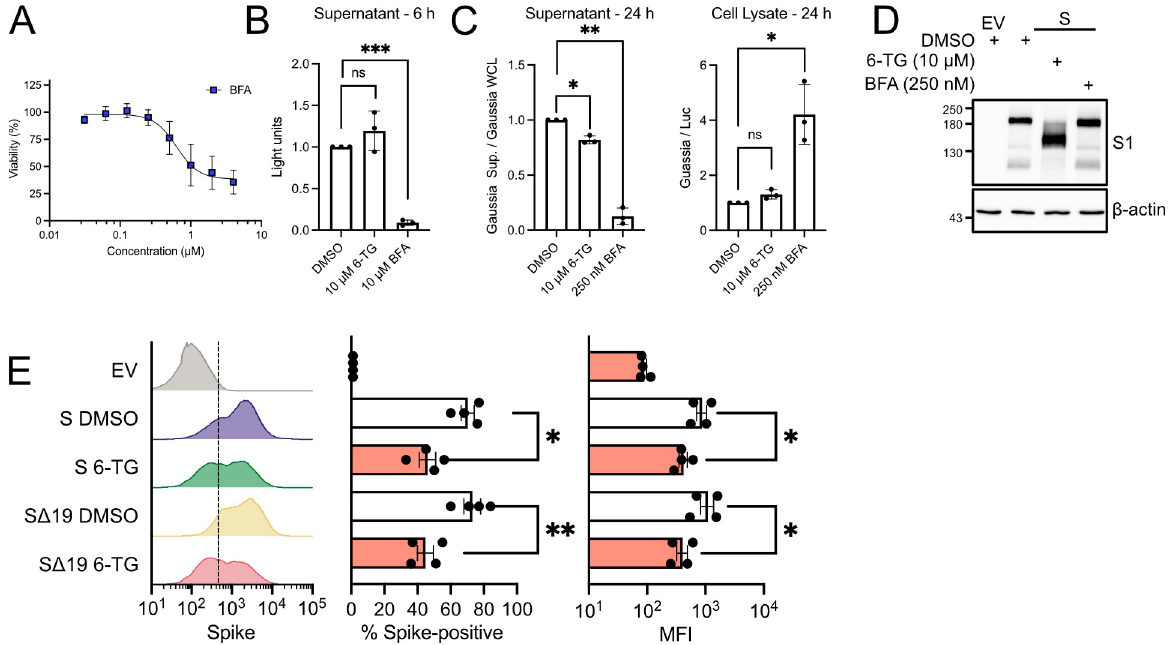
Fig 4. 6-TG reduces surface expression of Spike but does not globally limit secretion. (A) AlamarBlue cell viability assay of 293T cells treated with brefeldin A (BFA) (n = 4 ± SEM). (B) 293T cells were transfected with plasmid encoding Gaussia luciferase for 18 h then treated with 6-TG, BFA or DMSO vehicle control for 6 h. Supernatants were recovered from the cells and measured for luciferase activity. (C) 293T cells were transfected with plasmids encoding firefly luciferase and Gaussia luciferase then treated with 6-TG, BFA, or DMSO. After 24 h, supernatants were removed and analyzed as in (B). Cell lysate was harvested in Reporter Lysis Buffer and stored at -80˚C until luciferase and Gaussia luciferase activities were measured. (For B and C, n = 3 ± SEM, statistical significance was determined by paired t-test compared to DMSO-treated cells; � , p < 0.05; �� , p < 0.01; ��� , p < 0.001; ns, non-significant). (D) 293T cells were transfected with plasmids encoding SARS-CoV-2 Spike or EV then treated with 6-TG, BFA, or DMSO. Lysates were harvested 24 h after transfection in 2x Laemmli buffer and were probed by western blotting as indicated. (E) 293T cells were co-transfected with plasmids encoding EGFP and either Spike (S), Spike with 19 residue C-terminal truncation (S Δ 19), or EV and then treated with 10 μ M 6-TG or DMSO. After 24 h, cells were harvested, surface-stained for Spike then fixed prior to analysis by flow cytometry. EGFP+ cells were gated for analysis of the number of Spike+ cells and Median Fluorescent Intensity (MFI) (n = 4 ± SEM statistical significance was determined by paired t-test between 6-TG and DMSO treated cells; � , p < 0.05).